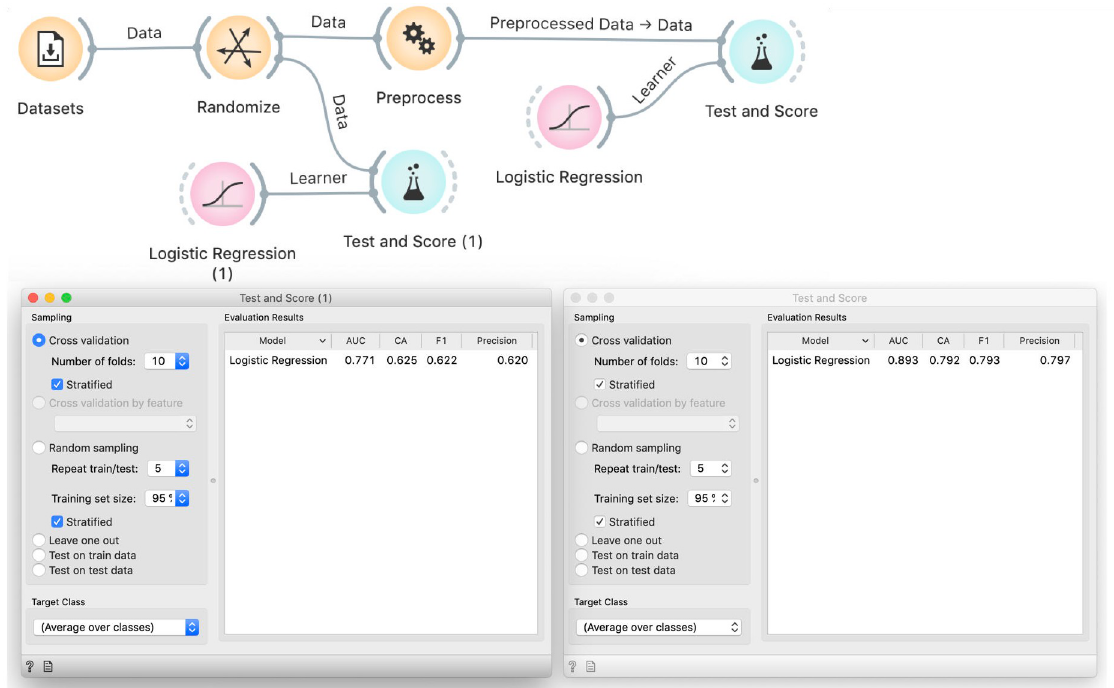
Fig 9. Comparison of models on all and on selected features from random data. Classification accuracy of logistic regression on all features is 62%, which is about the same as proportion of majority class. The model is thus no better the random guessing, as expected. This proves that feature selection is responsible for the overly optimistic